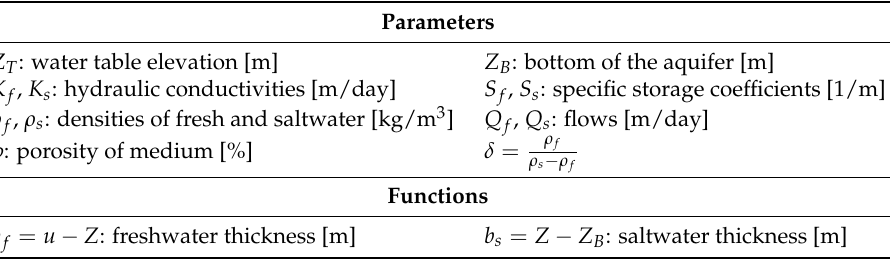
Table 1. Notations of parameters and functions used in system (1) and